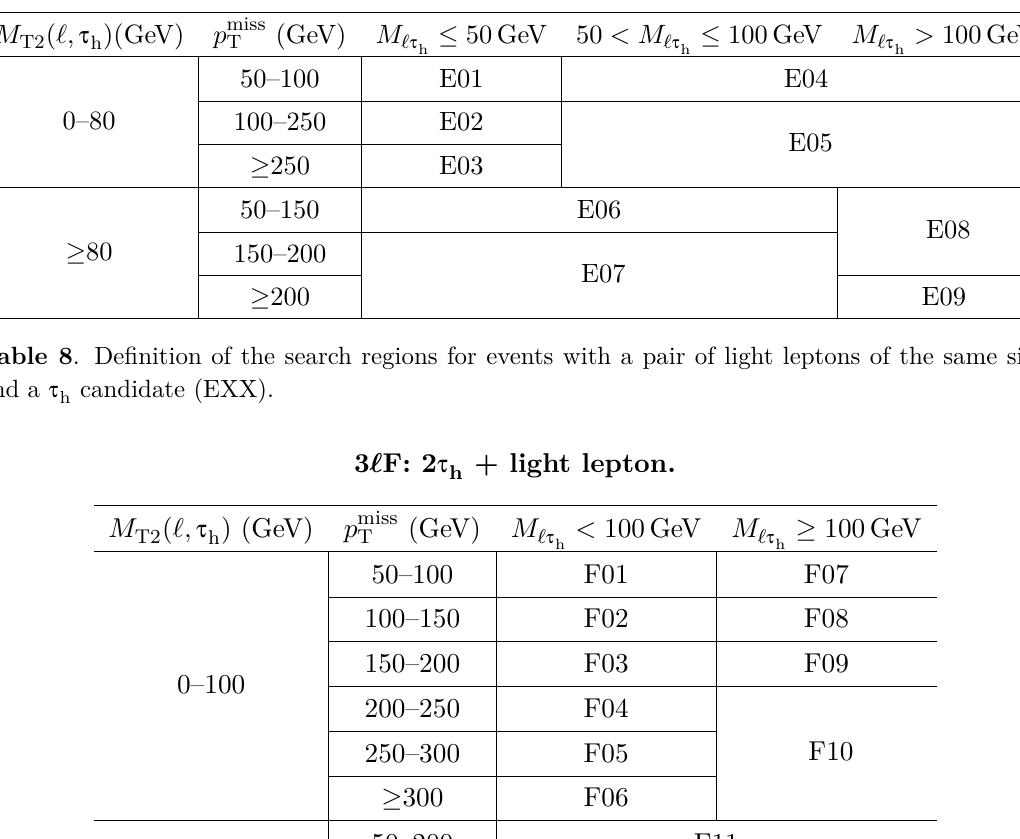
candidate (DXX). h . h